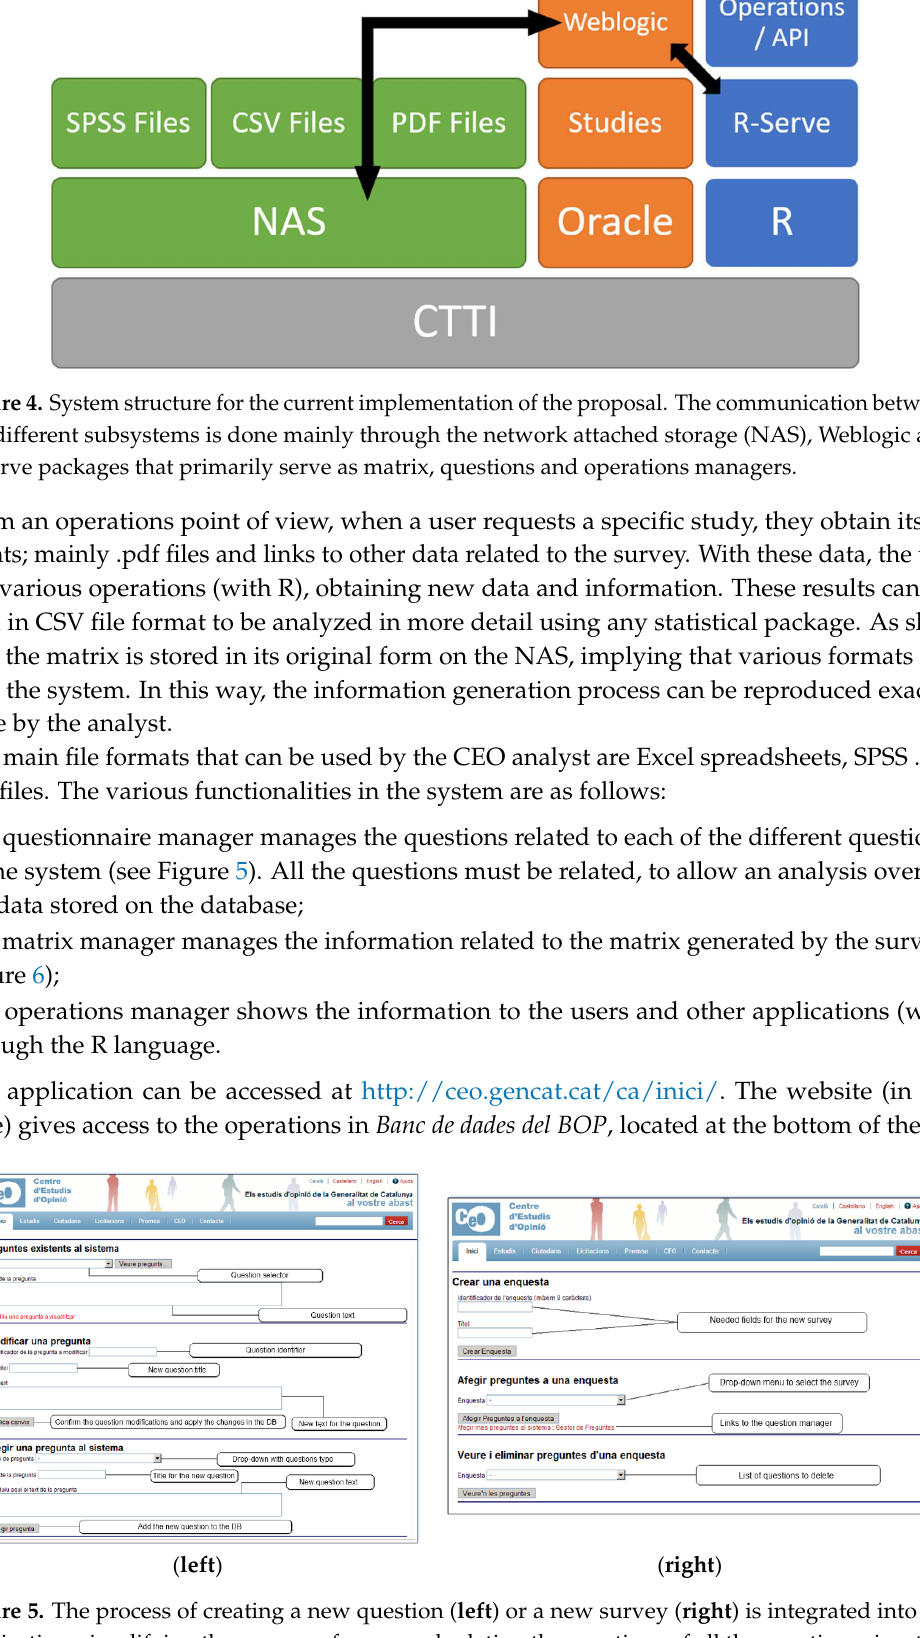
Figure 6. Uploading a new matrix containing the data of a survey to the system. 4. Implementation and Calibration of the Application The entire application resides as a cloud solution supported by the Generalitat de Catalunya , hosted by the Centre de Telecomunicacions i Tecnologies de la Informació (CTTI). In this Cloud solution, the options to work and to modify the uploaded code are limited, as explained in Section 3. Because of the complexity of the structure and the required security concerns, a test infrastructure was implemented to assess the R operations. The test infrastructure is composed of a server and a client. On the server side, a machine acts as a web server (using IBM WebLogic), hosting the MySQL database, storing the data on the NAS (network attached storage) and executing R-Serve. On the client side, a java program (named JGUIforR; see Figure 7) is used to define the Graphical User Interface (GUI) and the R code needed to execute the operations and manage the matrices. The client application must first be connected with the server side. The IP of the R server instance we want to use is defined. In this case, the application is connecting with a server that is executed on the same machine as the JGUIforR.